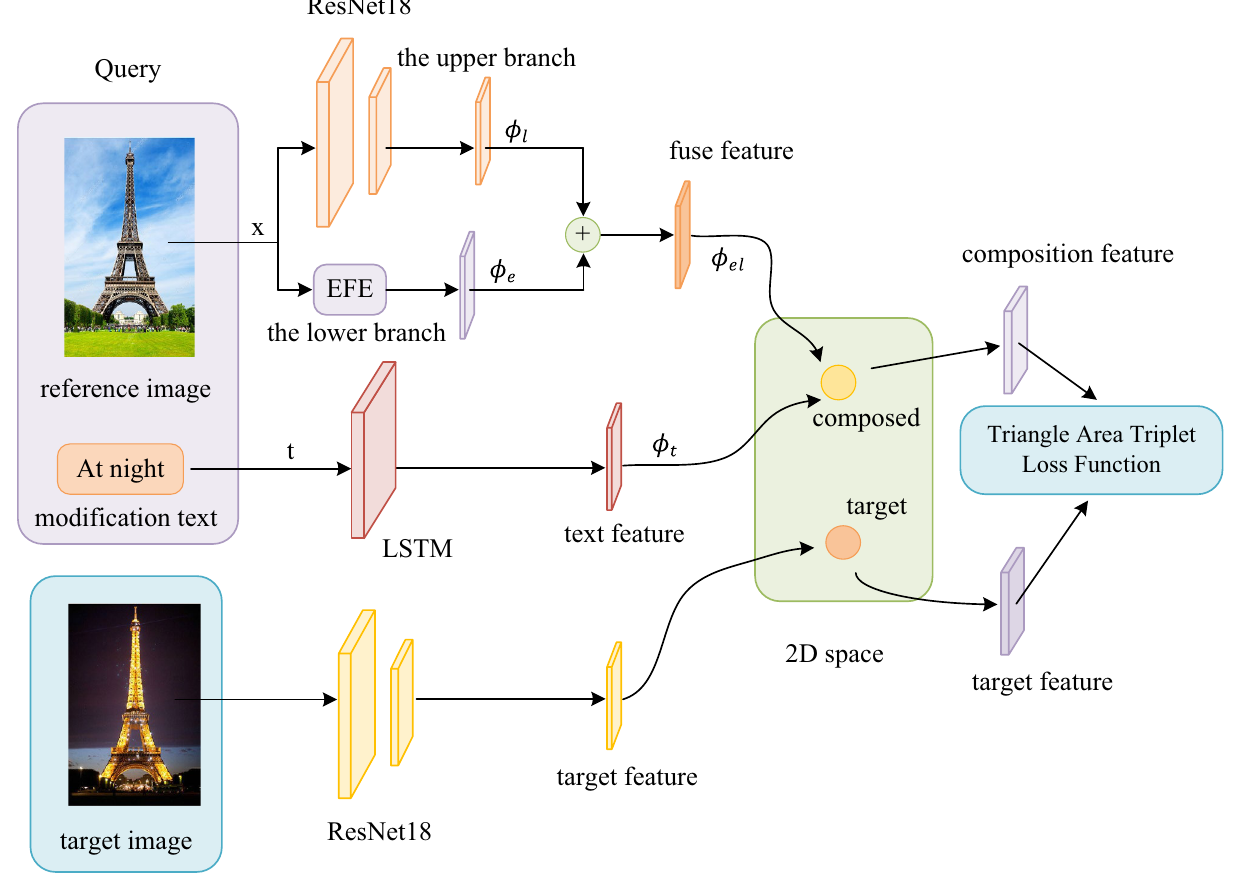
Figure 3. The system pipeline for training. CNN and Edge Feature Extraction (EFE) module are used to encode the reference image x. LSTM is used to extract text features. Finally, train the model via TATLF. (Created